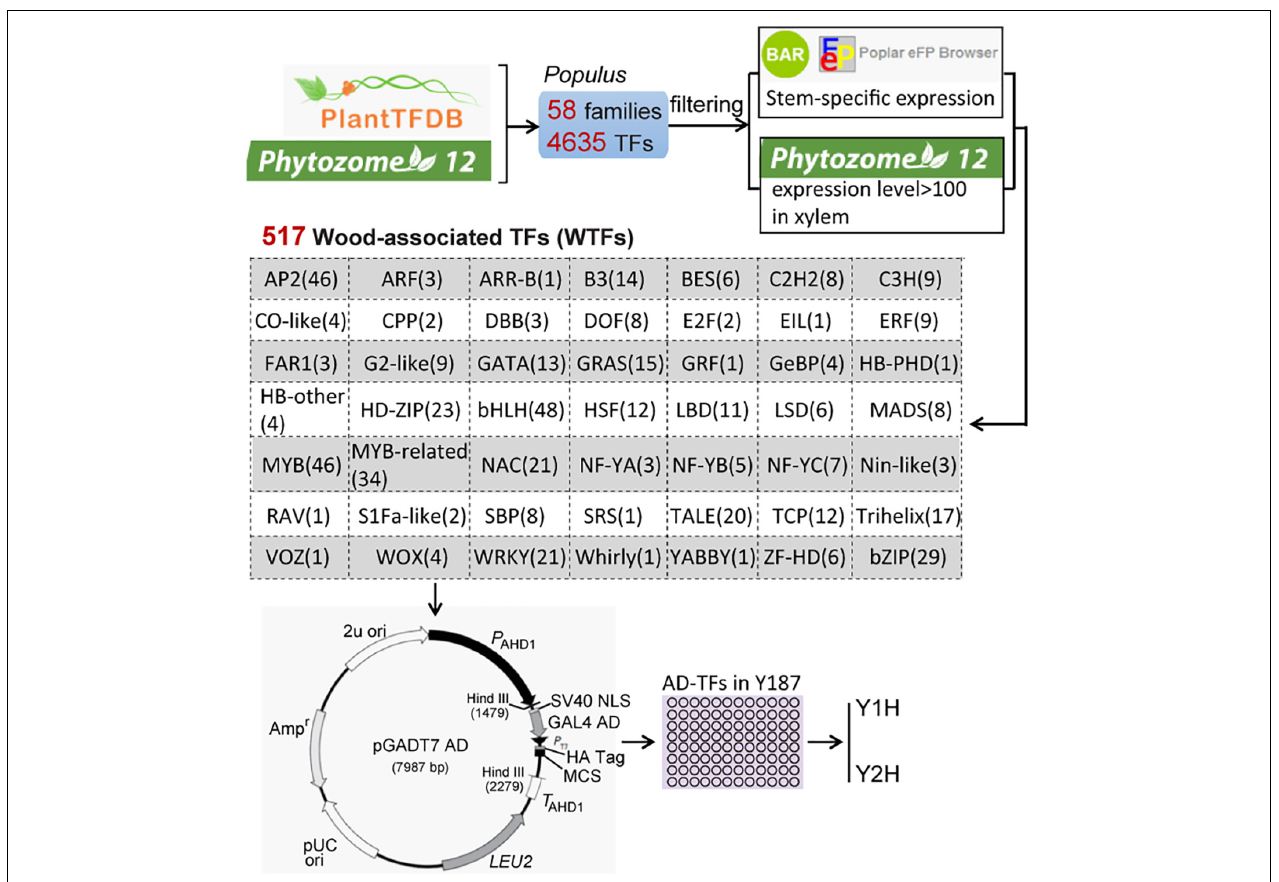
FIGURE 1 | The scheme of the construction of a wood-associated transcription factors (TFs) library. A total of 517 Wood-associated TFs (WTFs) were identified from 4287 Populus TFs of 58 gene families in two database (PlantTDB and Phytozome 12) using the stringent filtering criteria. All pGADT7-TFs were independently transformed into the yeast strain Y187 for throughout mating-based Y1H or Y2H